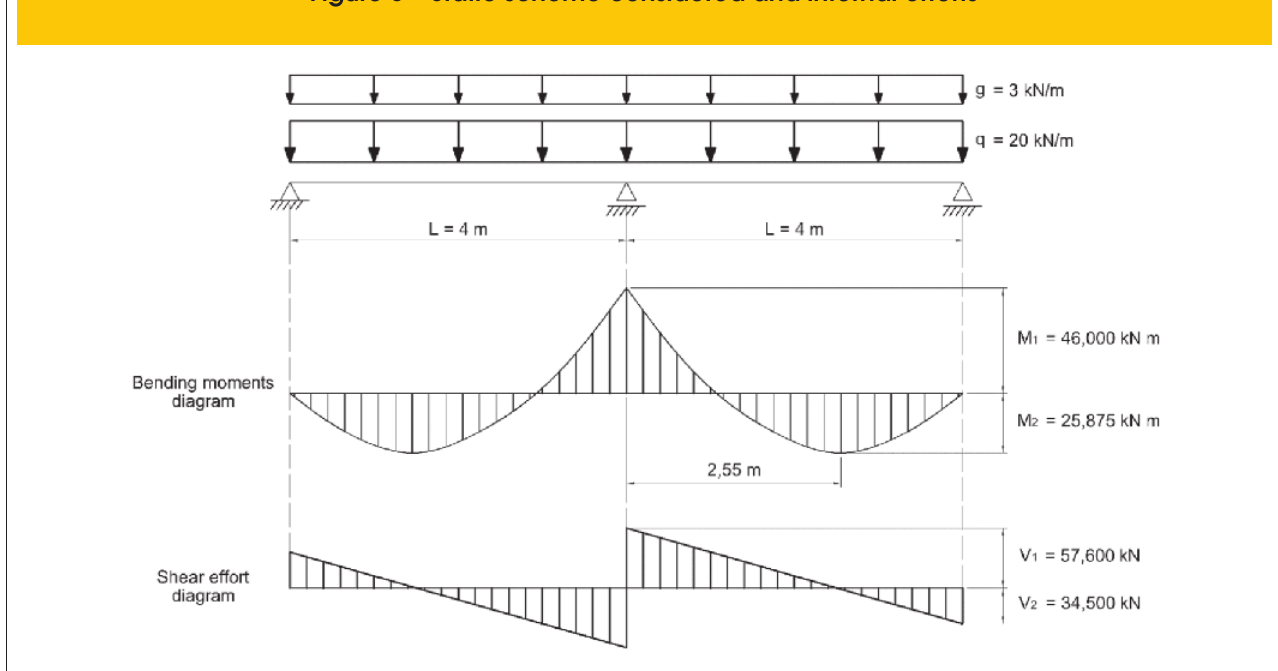
Figure 3 – Static scheme considered and internal efforts